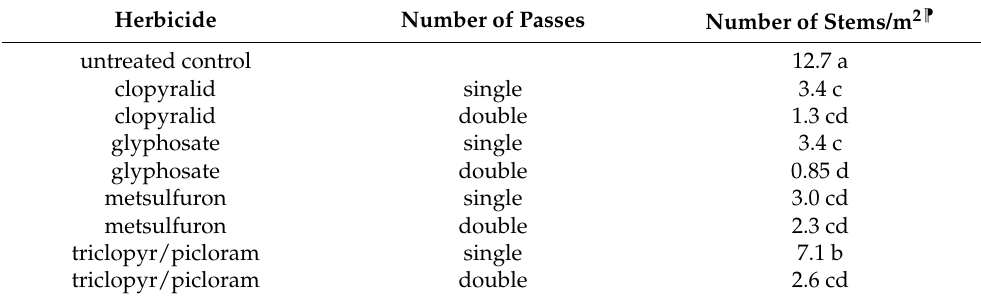
Table 3. The C. arvense stem density resulting from single and double passes of wiping four herbicide treatments, assessed 10 months after application.